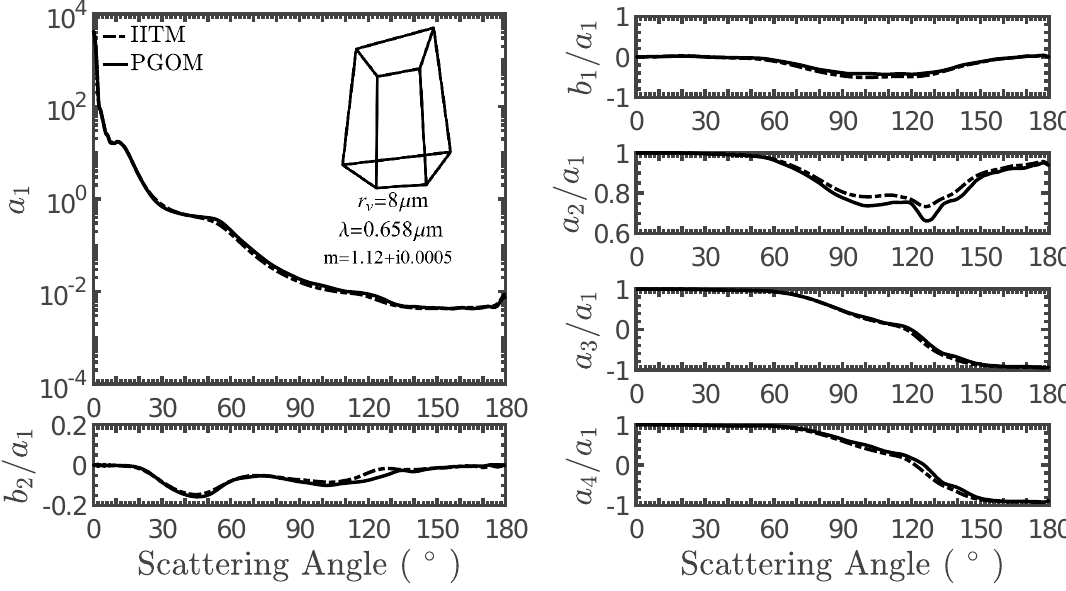
Figure 4. Comparisons of Mueller matrix elements of a hexahedron particle calculated by the IITM and the physical-geometric optics method (PGOM). The volume equivalent sphere radius is 8 µm and the incident wavelength is 0.658 µm. The relative refractive index is 1.12 + i0.0005.